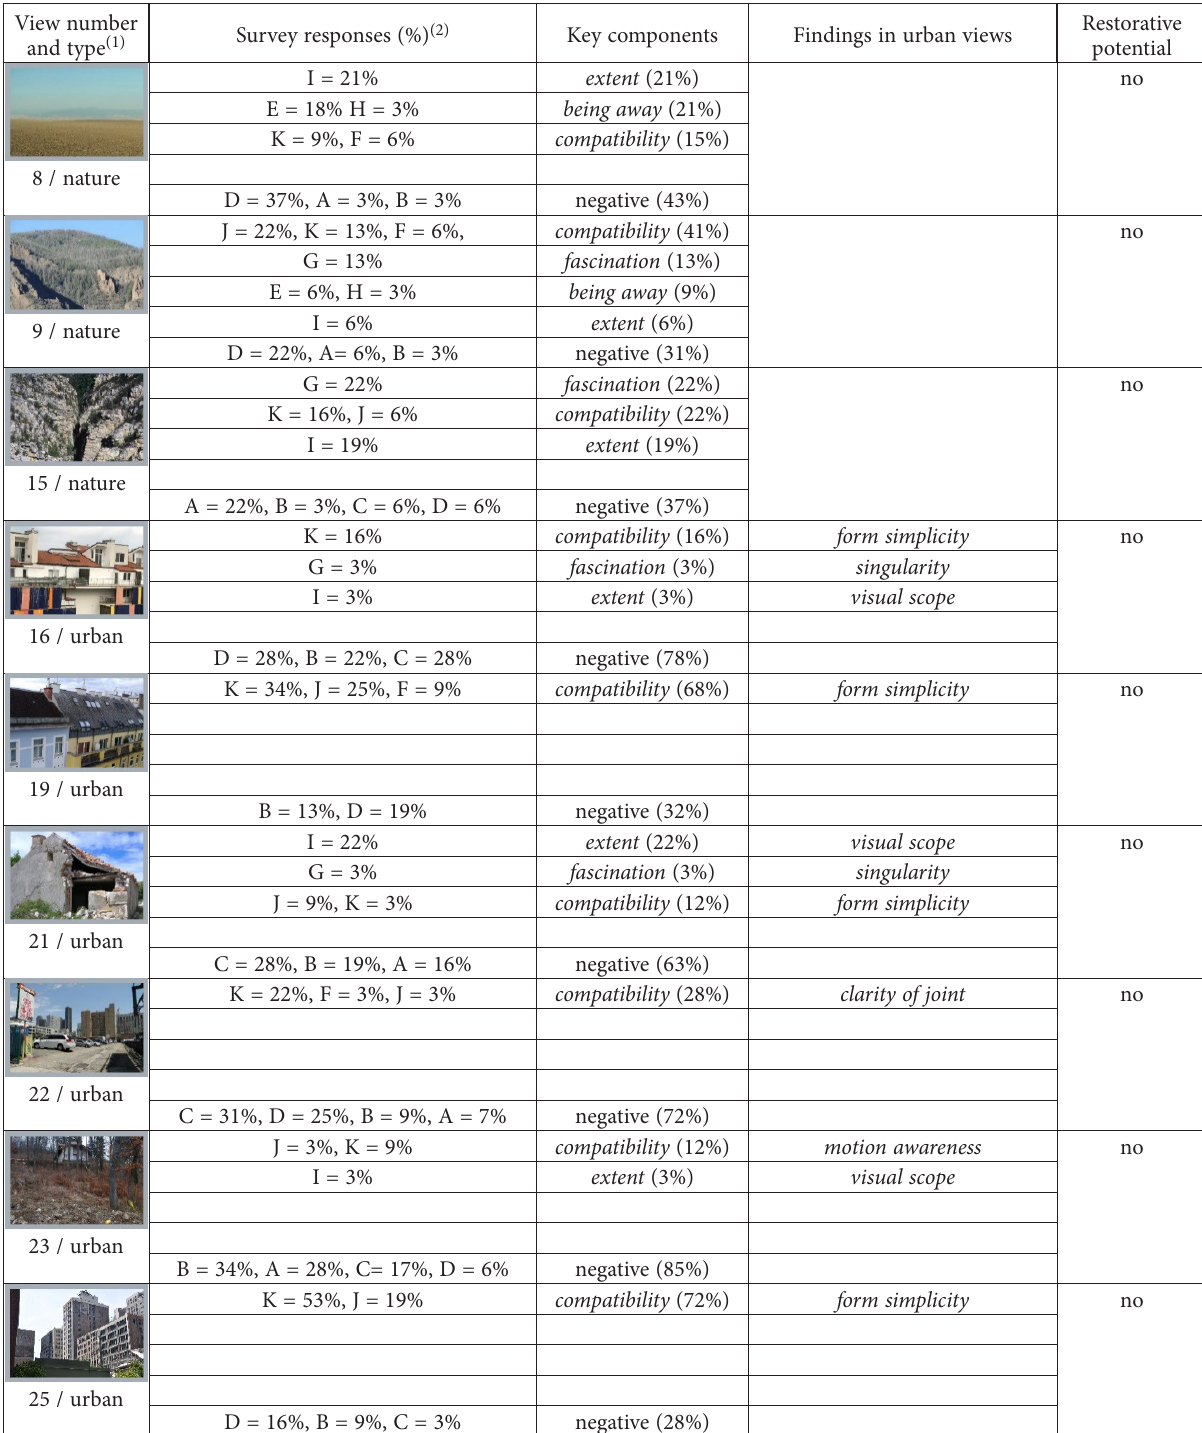
Table 4. Natural and urban window view with predominant negative